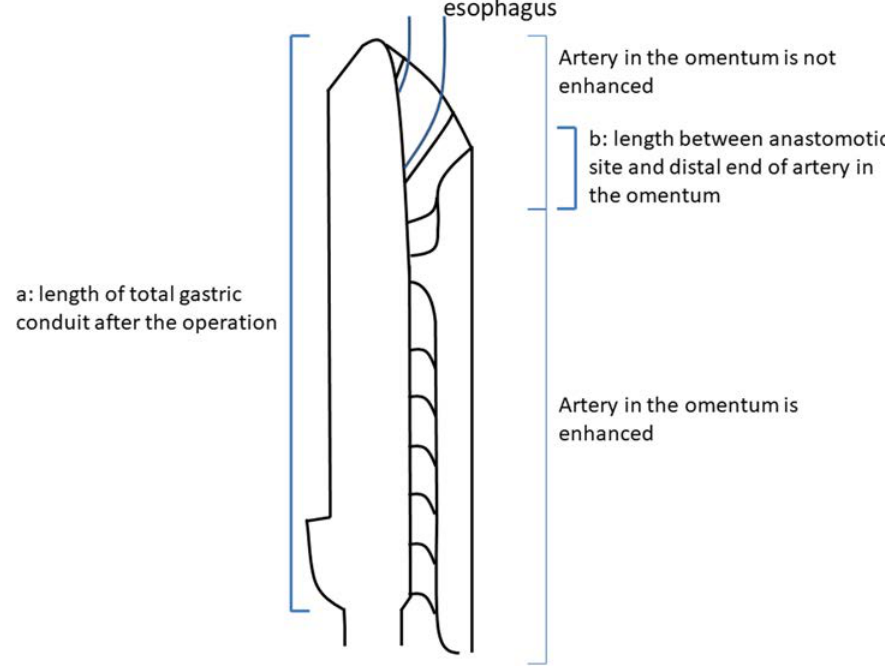
Figure 2 Measured values of the 3-cm-wide gastric conduit on postoperative